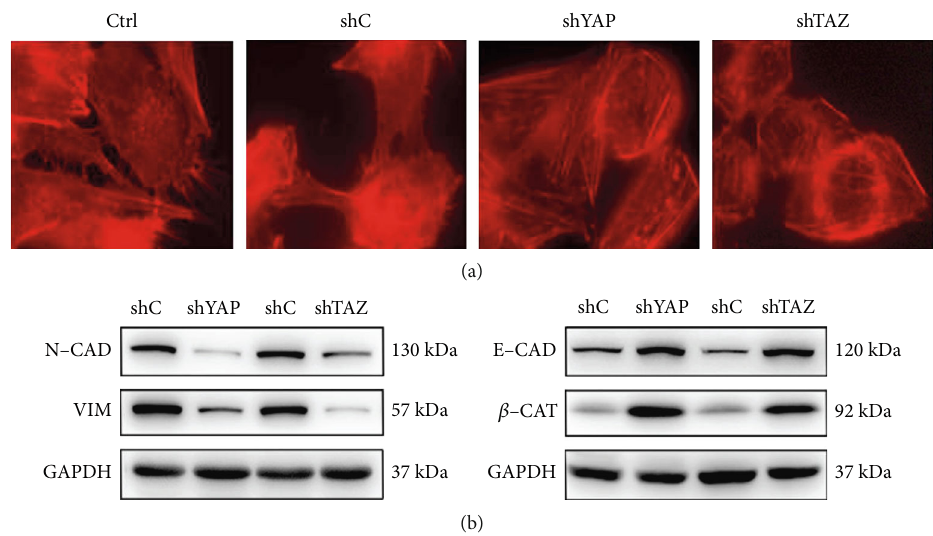
Figure 4: Knockdown of YAP or TAZ reduced epithelial-mesenchymal transition (EMT) of RA-FLS. (a) The distribution of actin fi bers in stable YAP or TAZ knockdown RA-FLS was determined by immuno fl uorescence staining with rhodamine-labeled phalloidin, n = 3 . Magni fi cation, × 1000. (b) Protein levels of EMT markers were determined by western blot from RA-FLS stably expressing shRNA speci fi c for YAP (shYAP), TAZ (shTAZ), and the corresponding vector control (shC), and GAPDH was used as a loading control. Representative blots are shown ( n = 3